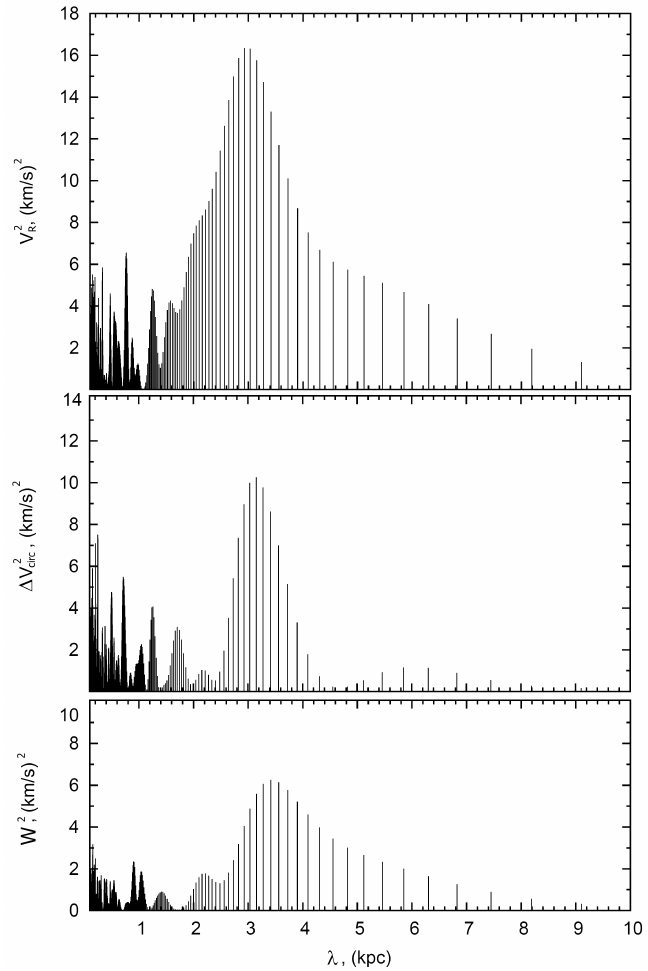
Fig. 2. Power spectra of the radial V R , residual tangential ∆ V circ , and vertical W velocities of